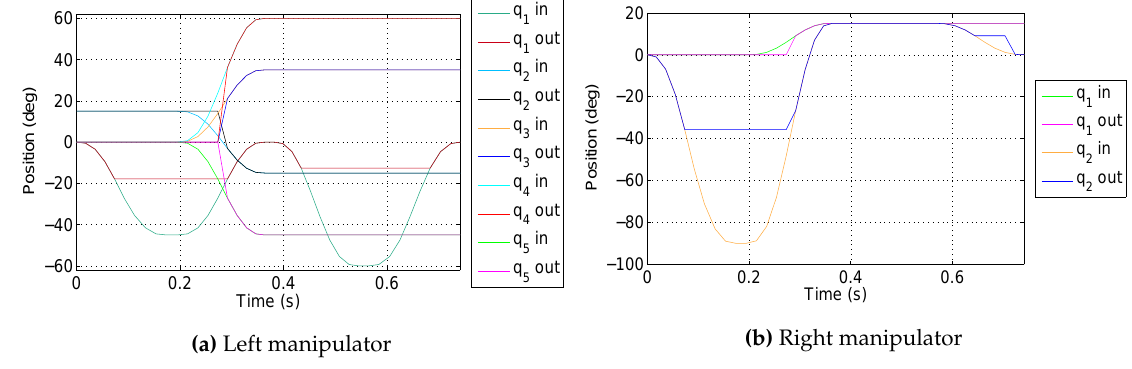
Figure 7. Reference input and collision-free output trajectories in joint space.